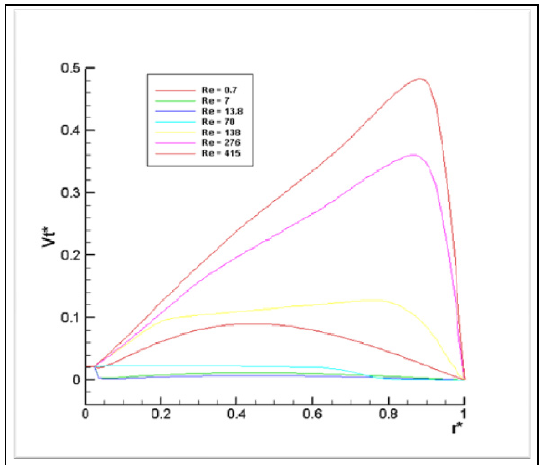
Fig. 3. Influence of inertia on the tangential velocity at the blade and its extension.